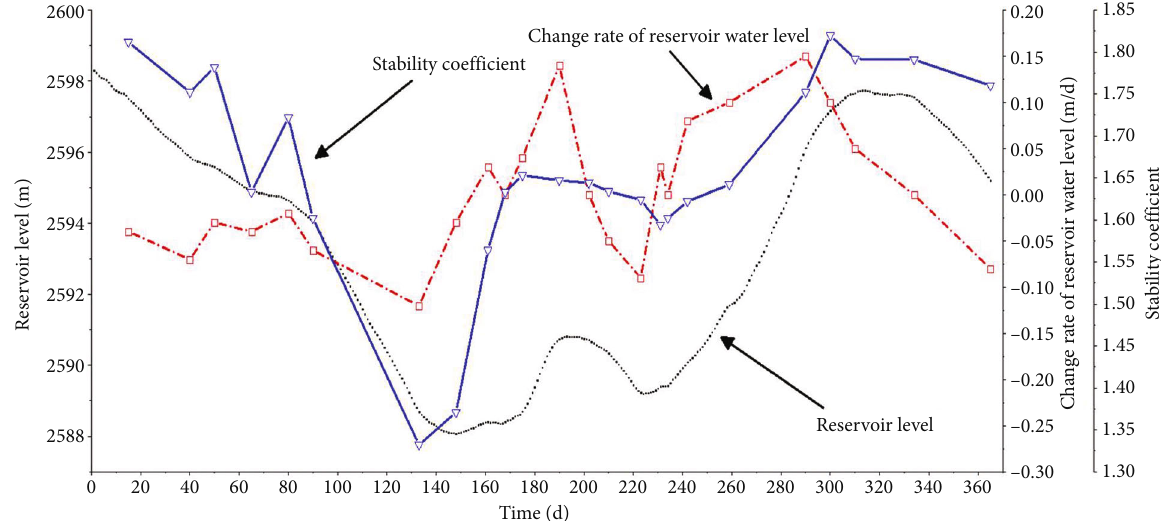
Figure 12: Variation curve of landslide stability coe ffi